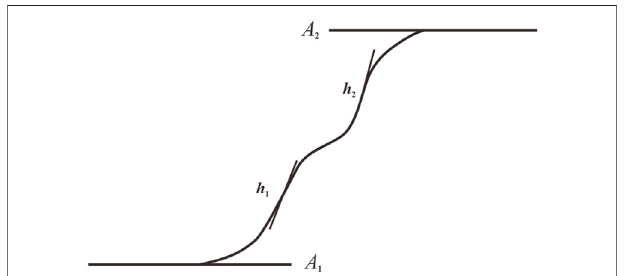
FIGURE 9 | BiDoseResp function characteristics.